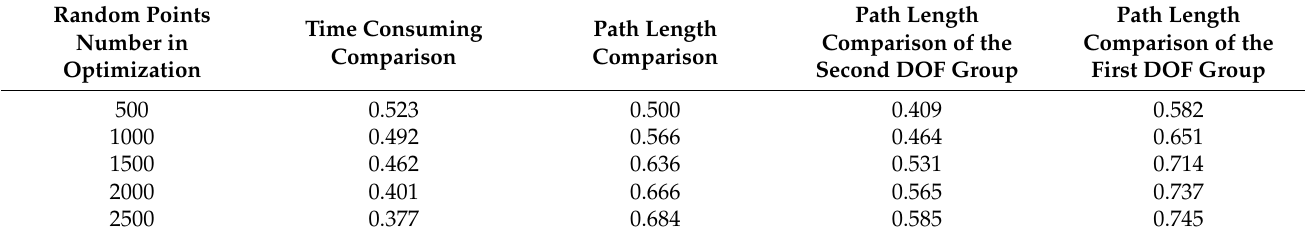
Table 4. Experimental results.